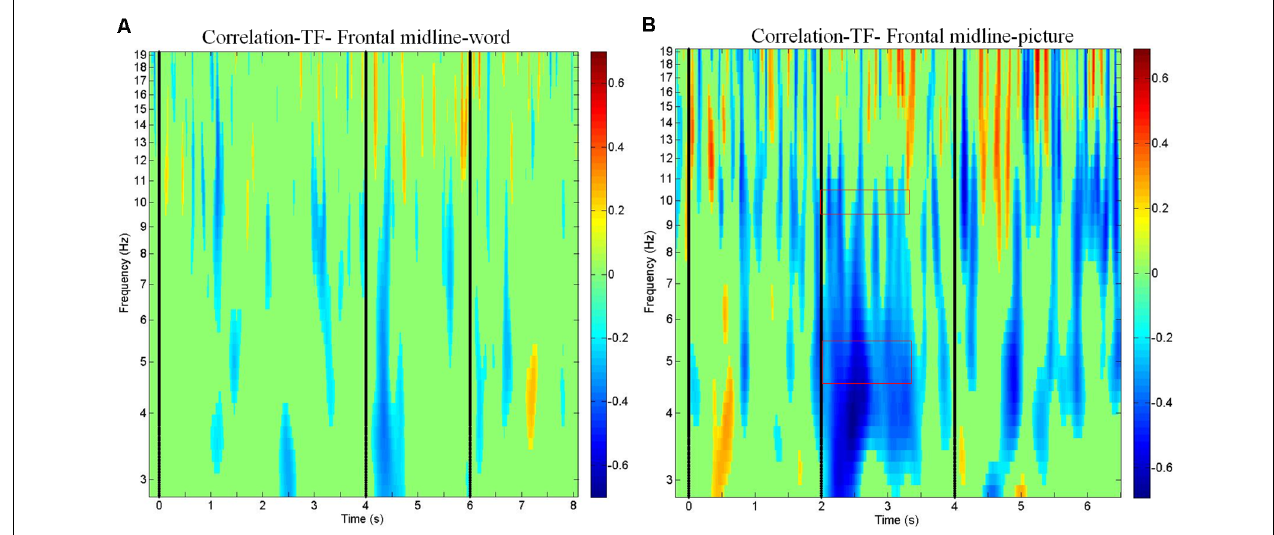
FIGURE 4 | Correlations between electroencephalogram (EEG) spectrum and subject response (correct vs. incorrect) for the frontal midline cluster. Correlation plots show the correlations between EEG spectrum and subject response (correct vs. incorrect) in the time windows of the (A) word modality from − 200 to 8,100 ms and (B) picture modality from − 200 to 6,500